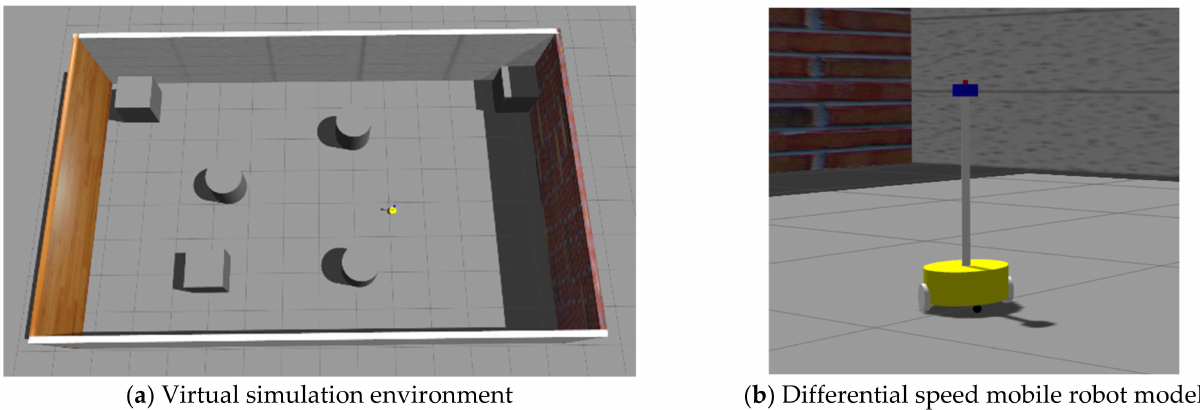
Figure 4. Simulation experiment environment. ( a ) is the virtual simulation scene, and ( b ) is the related model of the mobile robot in Gazebo. In ( b ), the yellow module is the mobile robot chassis, the blue module is the Velodyne 16-line LiDAR, and the red module is the IMU inertial measurement